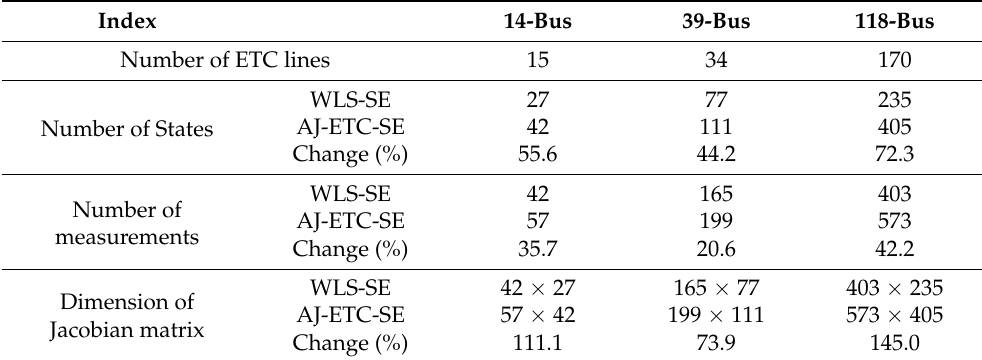
Table 5. Comparison of computational complexity of the AJ-ETC-SE approach and WLS-SE method.